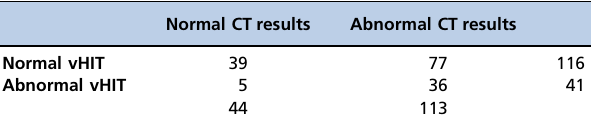
Table 1 - CT and vHIT test results.